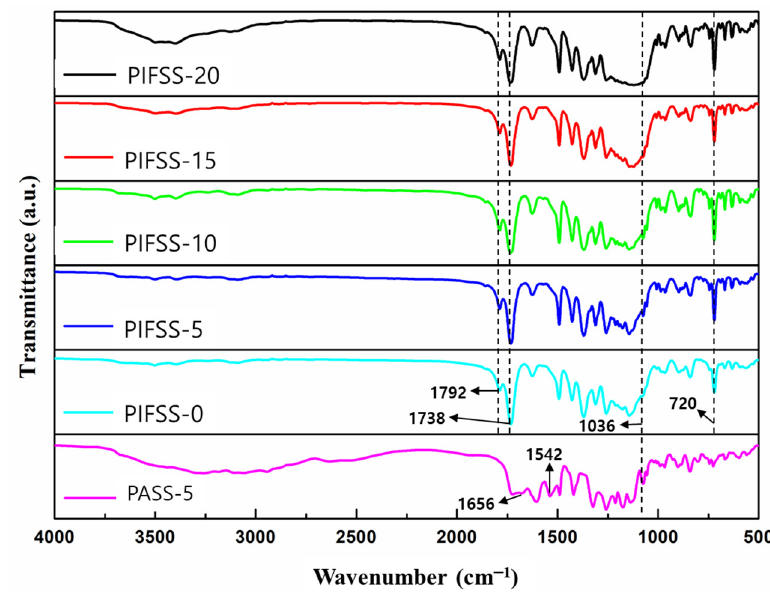
Figure 3. FT-IR spectra of PIFSS and PASS-5 coating samples.